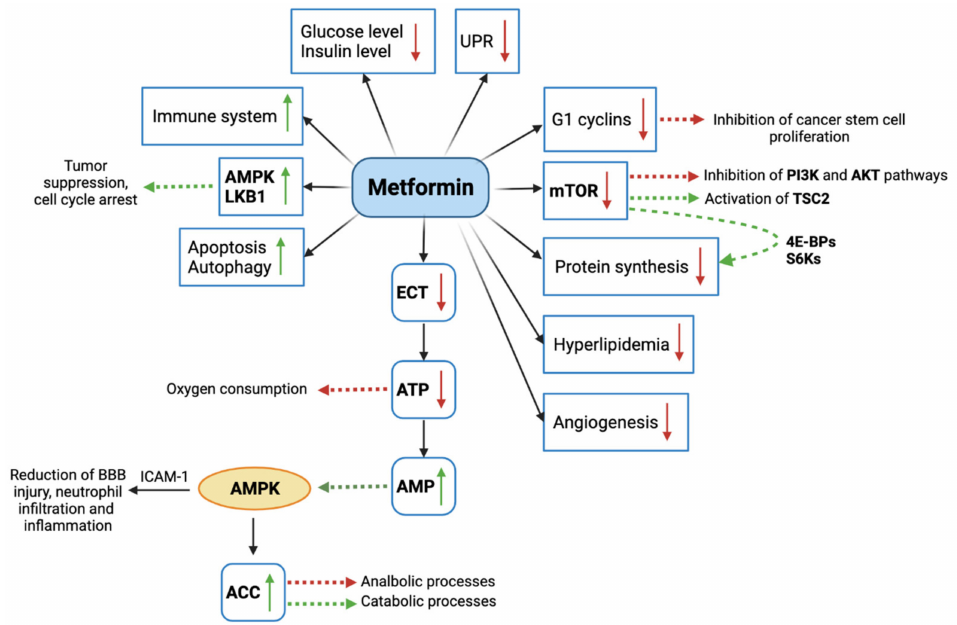
Figure 2. Graphic representation of molecular mechanisms mediated by metformin. mTOR: mam- malian target of rapamycin; PI3K: phosphoinositide 3-kinase; AKT: Protein kinase B; TSC2: TSC Complex Subunit 2; 4E-BPs: 4E-binding proteins; S6Ks: ribosomal protein S6 kinase; ECT: electron transfer chain; ATP: adenosine triphosphate; AMP: adenosine monophosphate; AMPK: adenosine monophosphate-activated protein kinase; ACC: acetyl coenzyme A carboxylase; ICAM-1: intercellular adhesion molecule-1; LKB1: Liver Kinase B1; UPR: unfolded protein response. Green arrows indicate activation and/or increased expression, red arrows indicate inhibition and/or decreased